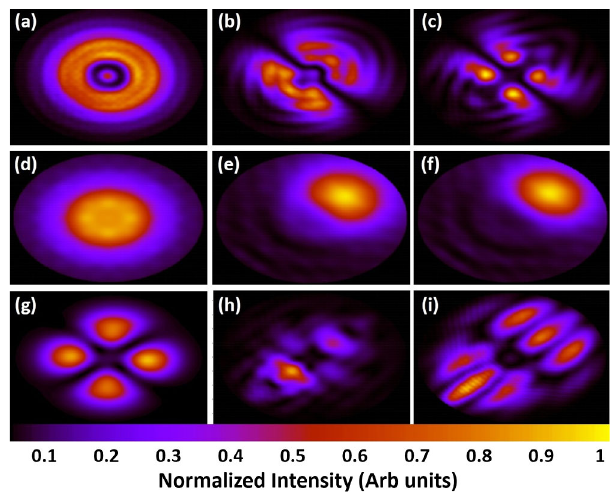
FIG. 14. Mode profiles from the simulations with a tilted mirror at a wavelength of 25 μ m and a hole size of 4 mm, for the confocal configuration ( g ¼ 0 ) with tilts of (a) zero, (b) 0.3 mrad, and (c) 0.5 mrad; for the concentric configuration ( g ¼ − 1 ) with tilts of (d) zero, (e) 0.1 mrad, and (f) 0.3 mrad; for the intermediate configuration ( g ¼ − 0 . 6 ) with tilts of (g) zero, (h) 0.1 mrad, and (i) 0.3 mrad. For each plot the window size is 50 mm by 50